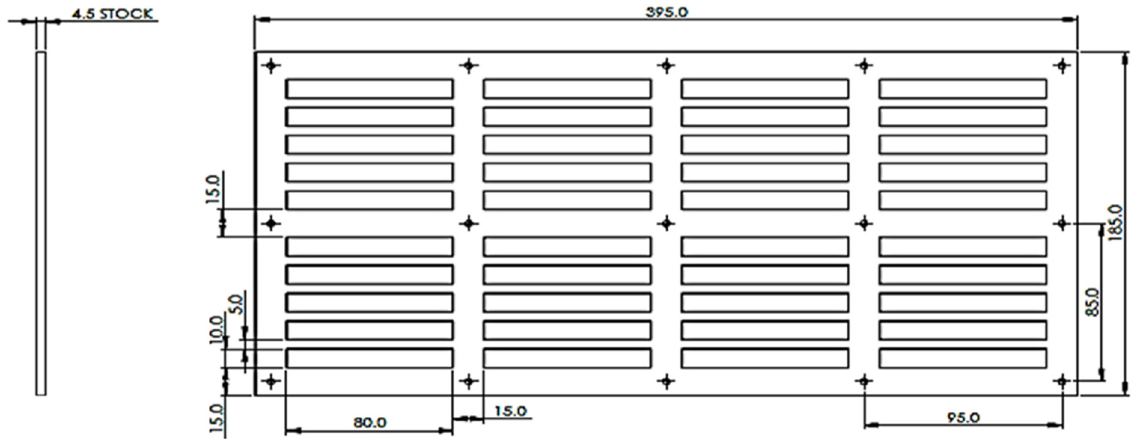
Figure 4. Images of a mould designed using SolidWorks ® software.